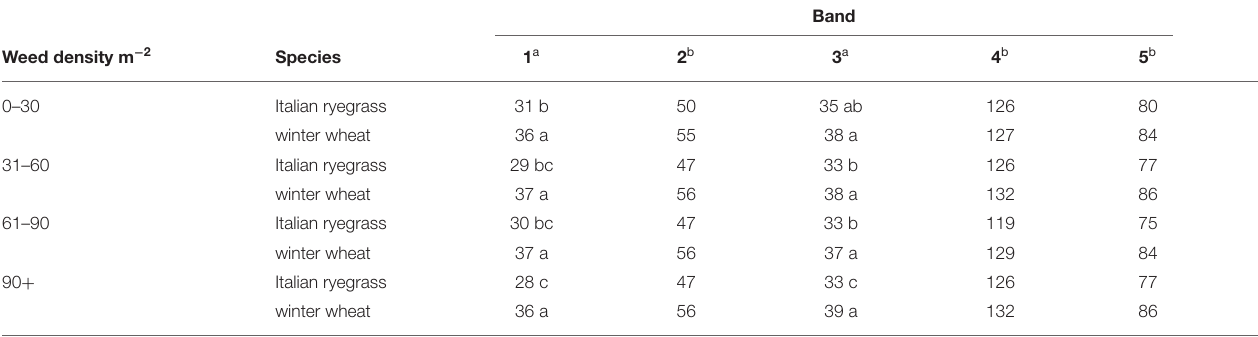
TABLE 4 | Spectral reflectance values within distinct bands of Italian ryegrass and winter wheat across different surrounding weed densities (Italian ryegrass).